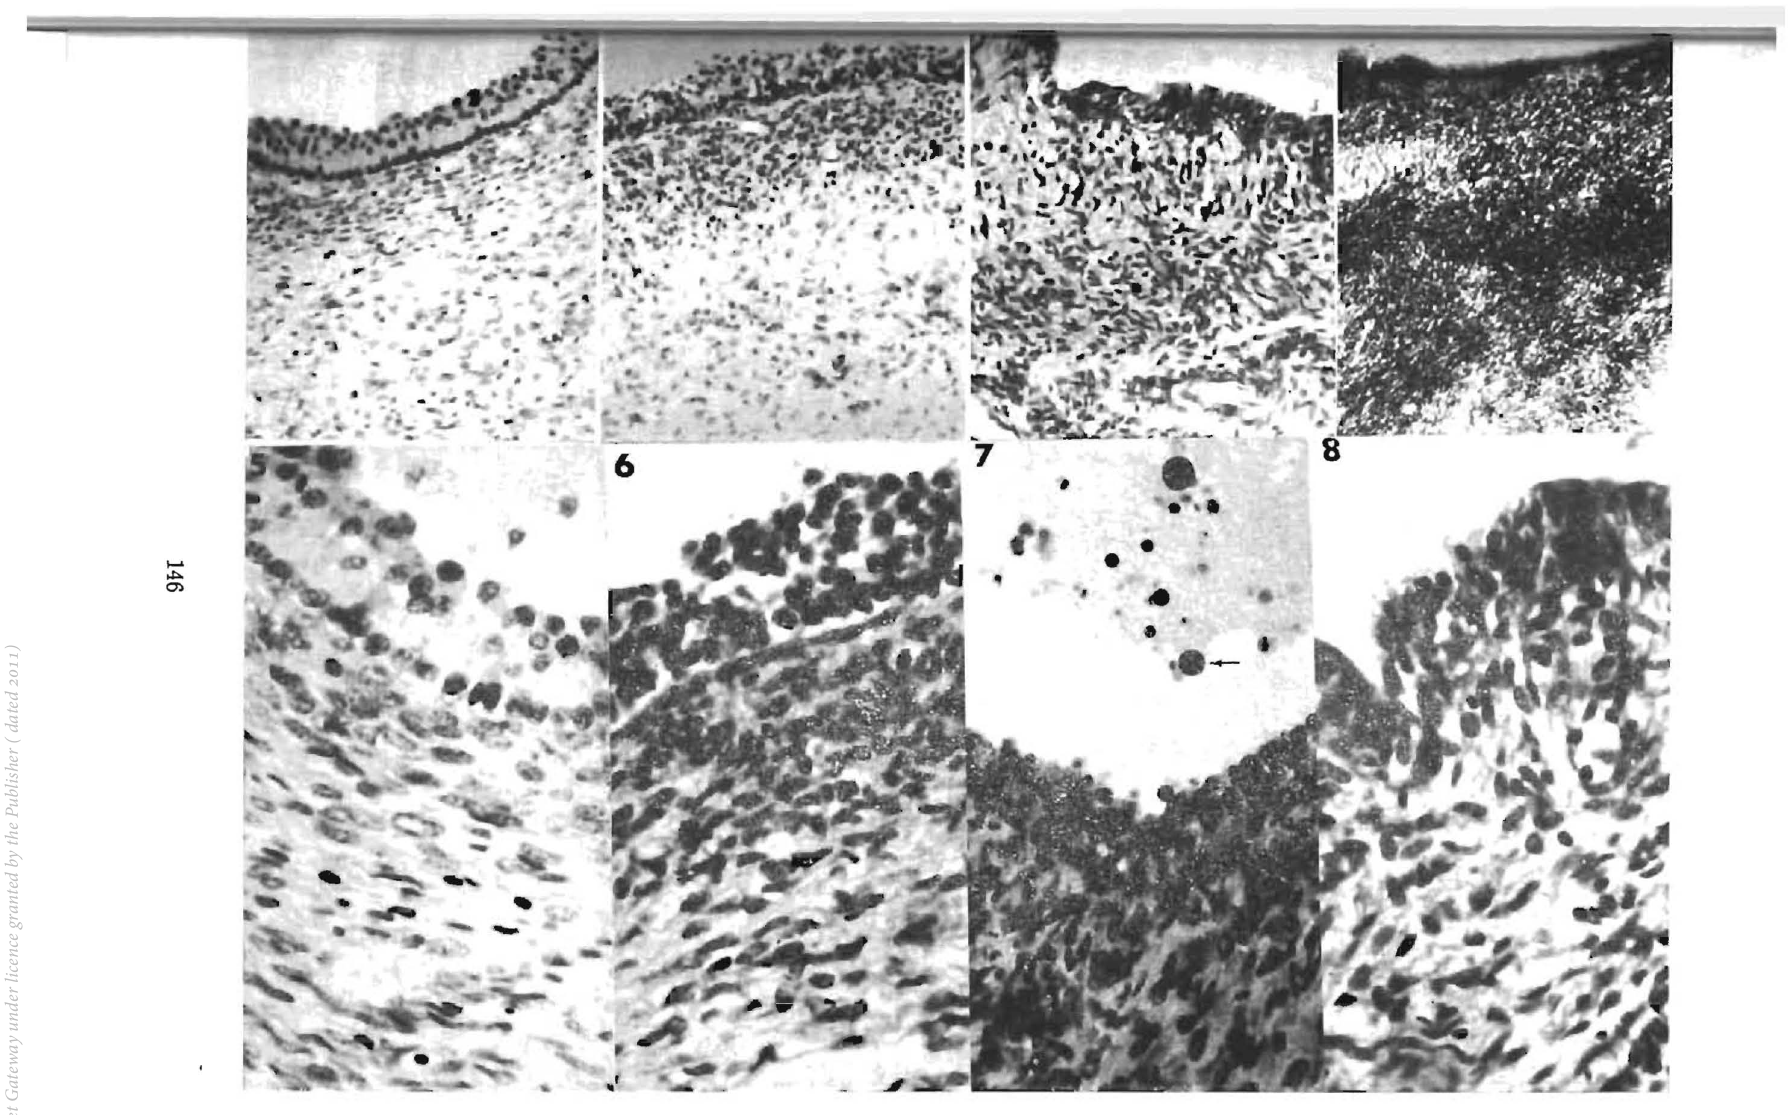
Fig. 1: ( x 80) Section of the W.111 of .1 Jm.111 norm.11 growing follicle. Note the we lI-org.1nized ur,il[um gr.1nulo~um with in bual l.1yer of call cuboid.11 cellJ with orOXlm.1lly .1rr.1nged nuclei. Differentiation between the theca 100ern.1 .1nd theca extern.1 h.1J not yet commenctd. Fig. 2: ( x 80) Section of the w.111 of .1 Jm.111 folliclt in tht fint uageJ of .1trtJI.1. Note tht dlJorg.1niutlon of tht Hruum gr.1nuloJum .J.nd dtJqu.1muion of iu diH.11 cel". The b.1ul layer of cell, He no lanier cubold.11. tht nuclei He no longtr arr.1nged in .1 row. Fig, 3: ( x 80) Section of the W.111 of a Jmall folliclt in .1 more .1dvanced Ha~e of atreJ'.1. MOH of the gr.1nulou ctlls h.1ve slouRhed off inca the antrum. The fibroblHts of tht un, differe"~'- 'ed theca l.1yers c. '\ccively or ,.. .. ... ng and inv.1dl the remain' 'racum RTln